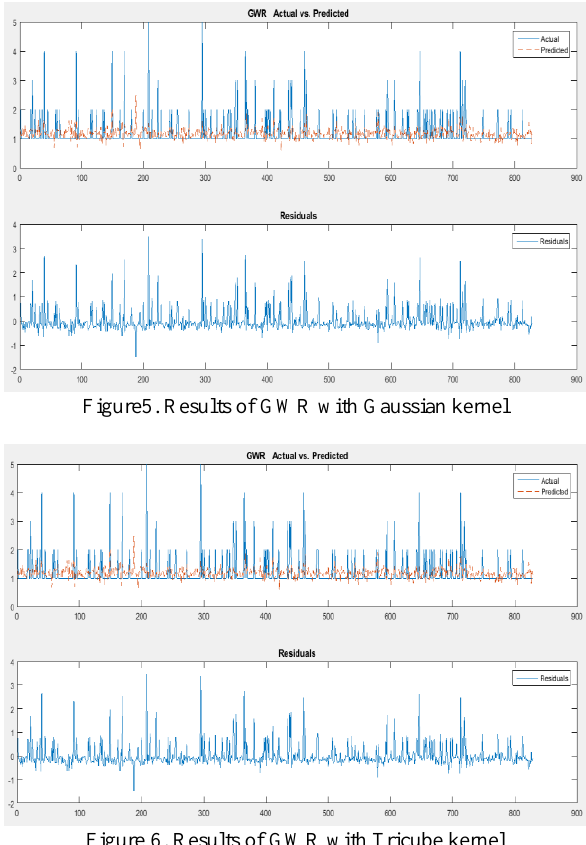
Table 2. The results of evaluation criteria for implemented algorithms